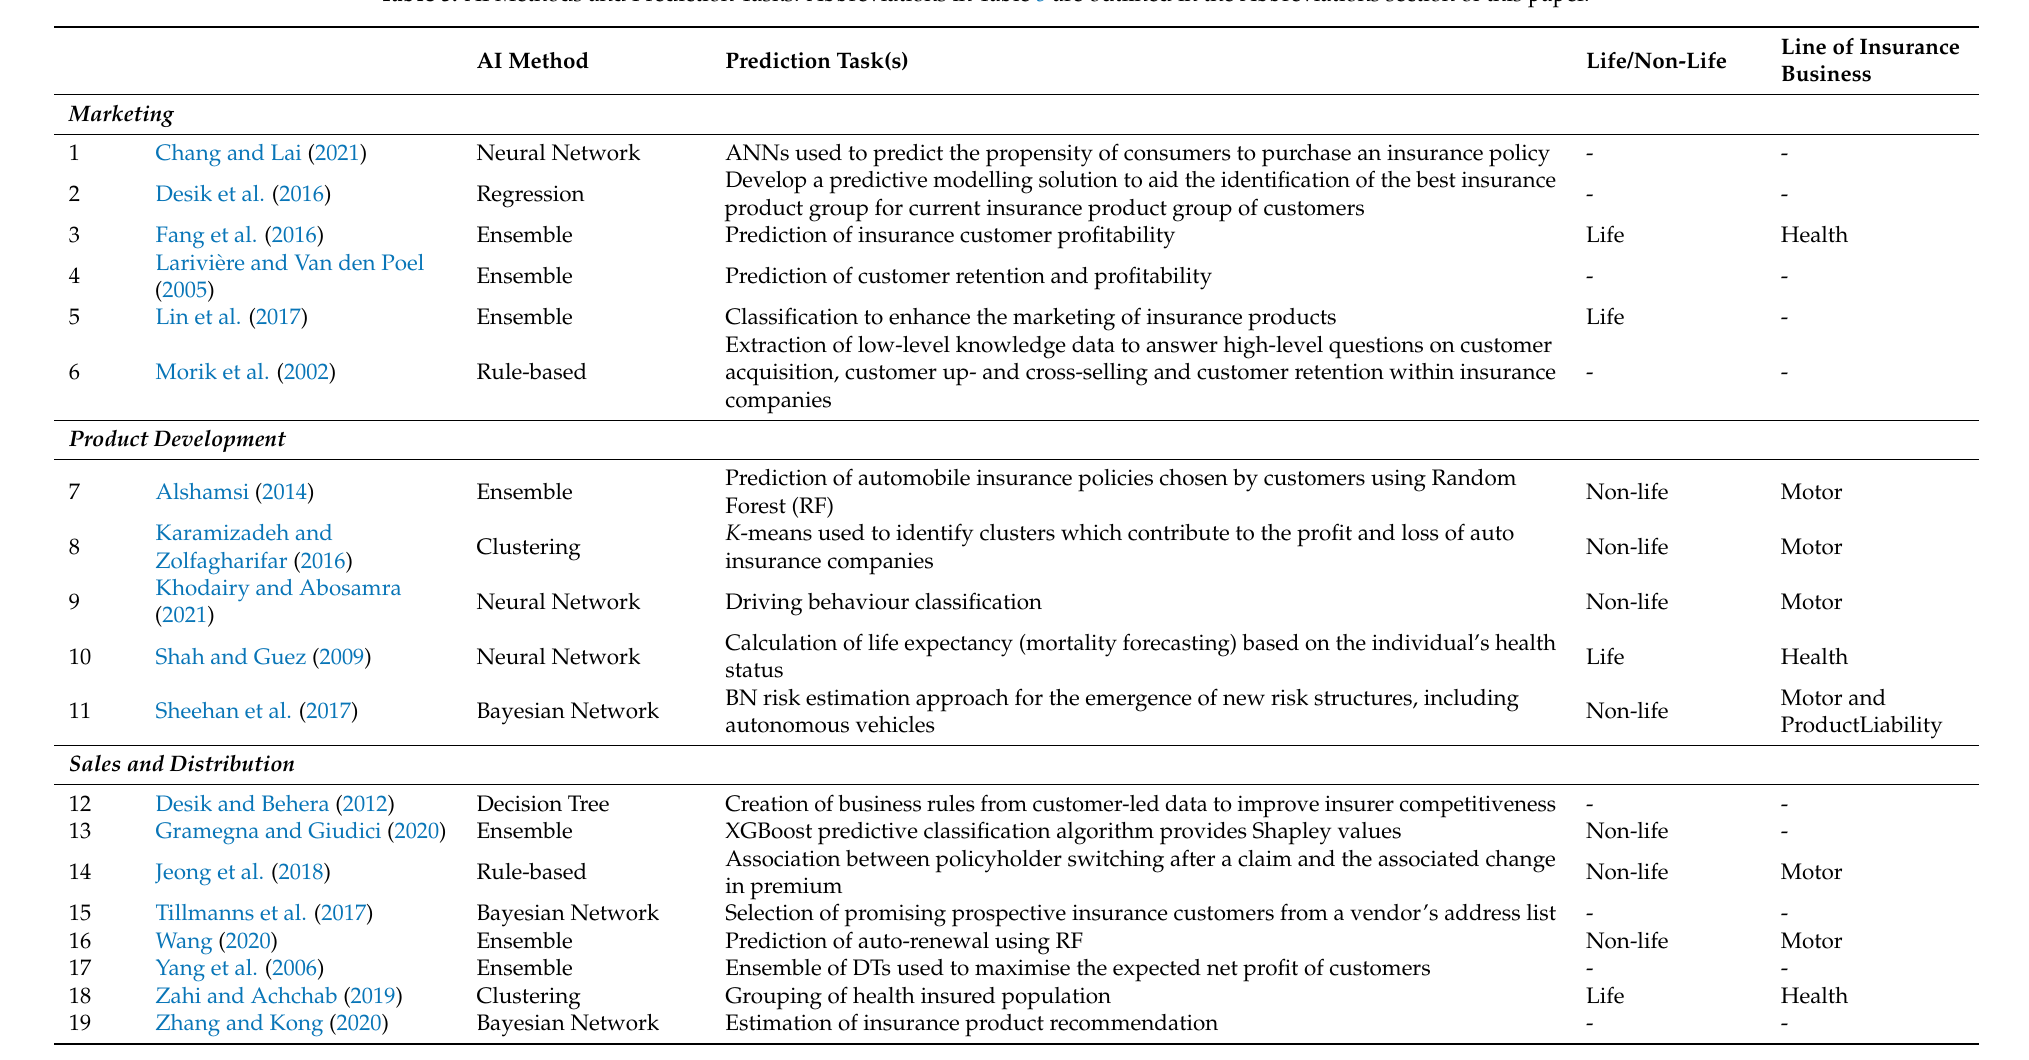
Table 5. AI Methods and Prediction Tasks. Abbreviations in Table 5 are outlined in the Abbreviations section of this